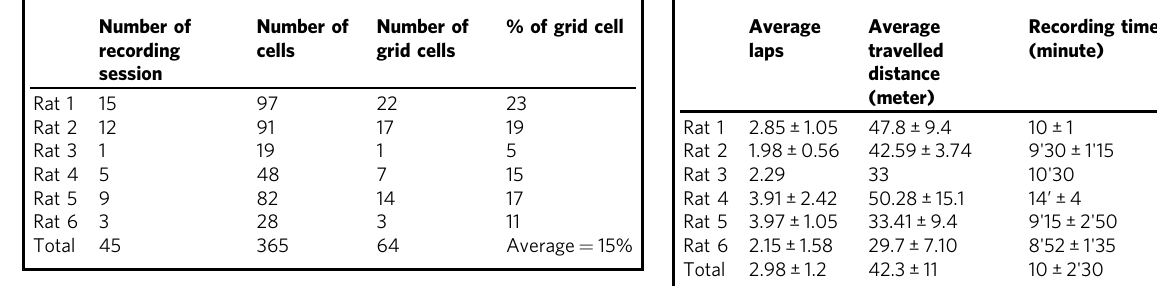
average distance between fi ring fi elds from the fi rst map, which we used to shift the laps of the second fi ring map. We con fi rmed that spatial correlation was signi fi cantly greater after the path- integrated distance correction than in pure allocentric coding (paired t -test on Z scores: t 28 = − 5.89780, p < 0.001). We also checked whether spatial correlation after distance correction was signi fi cant for individual neurons. Of 64 grid cells, 50 (78.1%) yielded a signi fi cant correlation in the integrated distance model (i.e. shifted fi ring position from lap to lap) while only 11 (17.2%) yielded a signi fi cant correlation in the allocentric model (i.e. stable fi ring position from lap to lap). The remaining